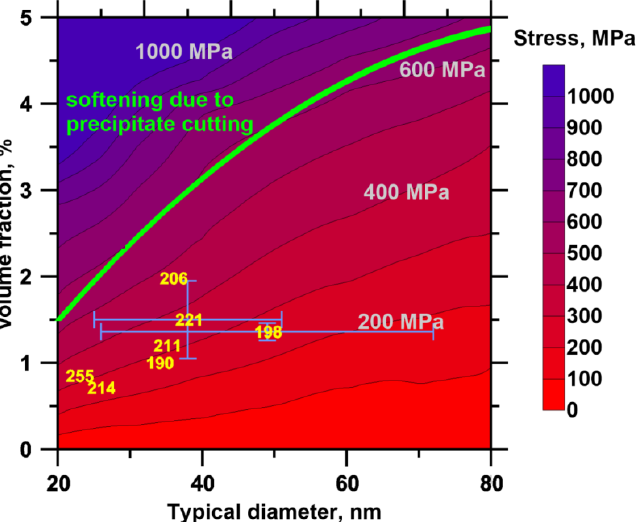
Figure 13. Dependence of maximal shear strength on volume fraction and typical diameter of θ ’ precipitates in Al–Cu alloy and region of strain softening due to precipitate cutting: Results of 2D dislocation dynamics accounting for precipitate evolution. Diagram is supplemented with experimental data on yield stress in Al–Cu alloy [37], given points corresponding to the experimental data on typical diameter and volume fraction of θ ’ precipitates; additionally, maximal absolute errors in experimental data are indicated.